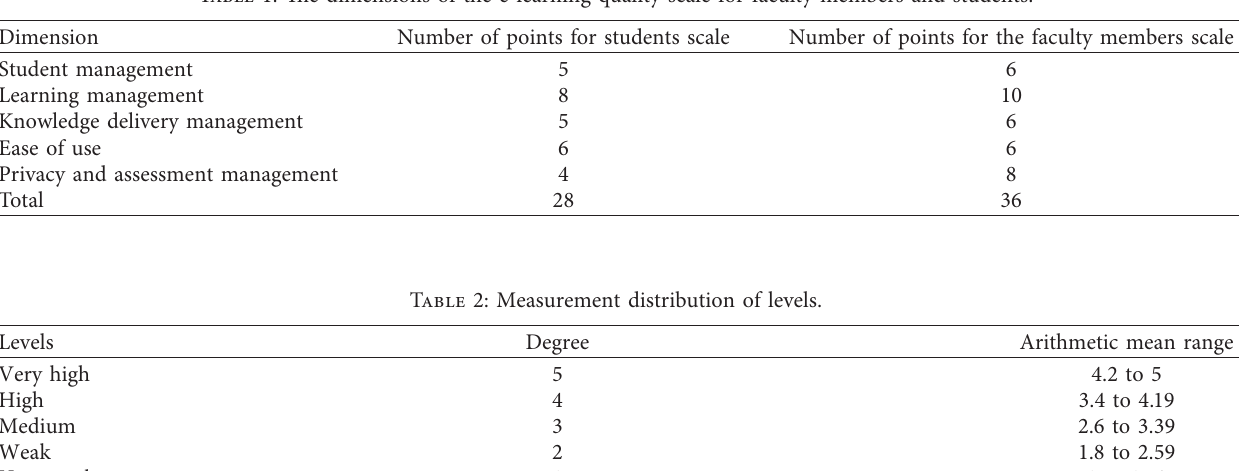
Table 1: The dimensions of the e-learning quality scale for faculty members and students.